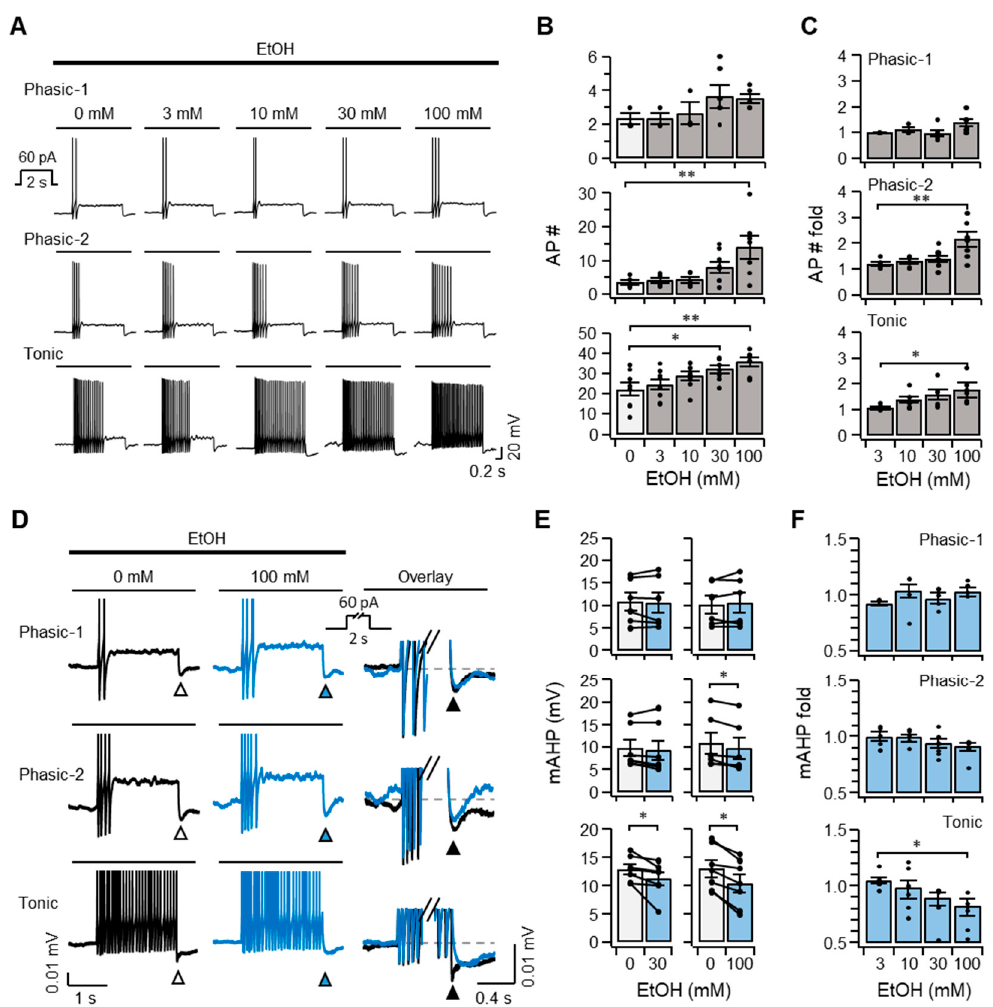
Figure 3. Superior cervical ganglia (SCG) neurons exhibit an increase in action potential discharges and a decrease in medium after-hyperpolarization (mAHP) in response to ethanol in a cell type-specific manner. ( A ) Representative traces, showing action potential discharges elicited by an injection of 60 pA for 2 s into each cell type incubated with the indicated concentrations of ethanol for 40 s. The number ( B ) and fold-change of the action potentials ( C ) shown by each cell type in the absence or presence of ethanol ( n = 3–8). ( D ) Representative traces showing mAHP (triangles) elicited by an injection of 60 pA for 2 s into each cell type in the absence or presence of 100 mM ethanol for 40 s. The right trace shows the composite mAHP with or without ethanol. mAHP of individual samples ( E ) and the fold-change of mAHP ( F ) shown by each cell type in the absence (black symbols) or presence of ethanol (blue symbols). n = 3–7. Data are mean ± SEM. One-way analysis of variance (ANOVA) followed by Sidak’s posthoc test ( B , C , and F ) and Wilcoxon matched-pairs signed-rank test ( E ). * p < 0.05, ** p <